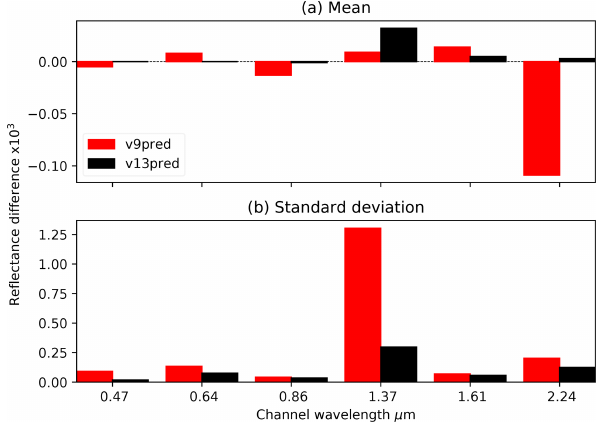
Figure 4. RTTOV vs. reflectances calculated from channel- integrated LBL transmittances for GOES-16 ABI visible/near-IR channels for v9 and v13 predictors with variable O 3 and CO 2 for the 83 training profiles. Note that the vertical scale is magnified by a factor of 1000.